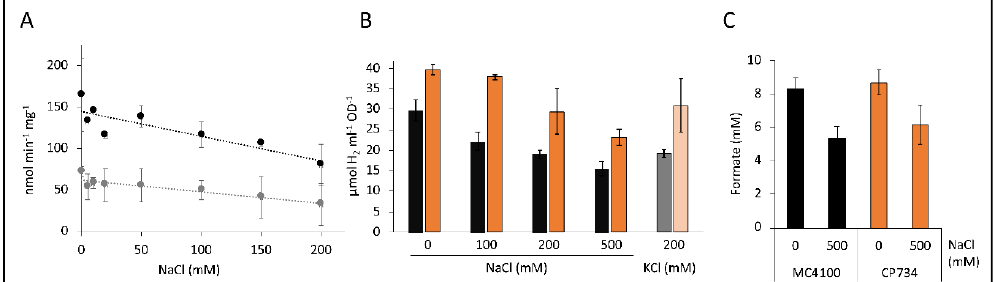
Figure 6. Effect of cations on H 2 production. Panel ( A ) shows the kinetic H 2 production rates of CP734